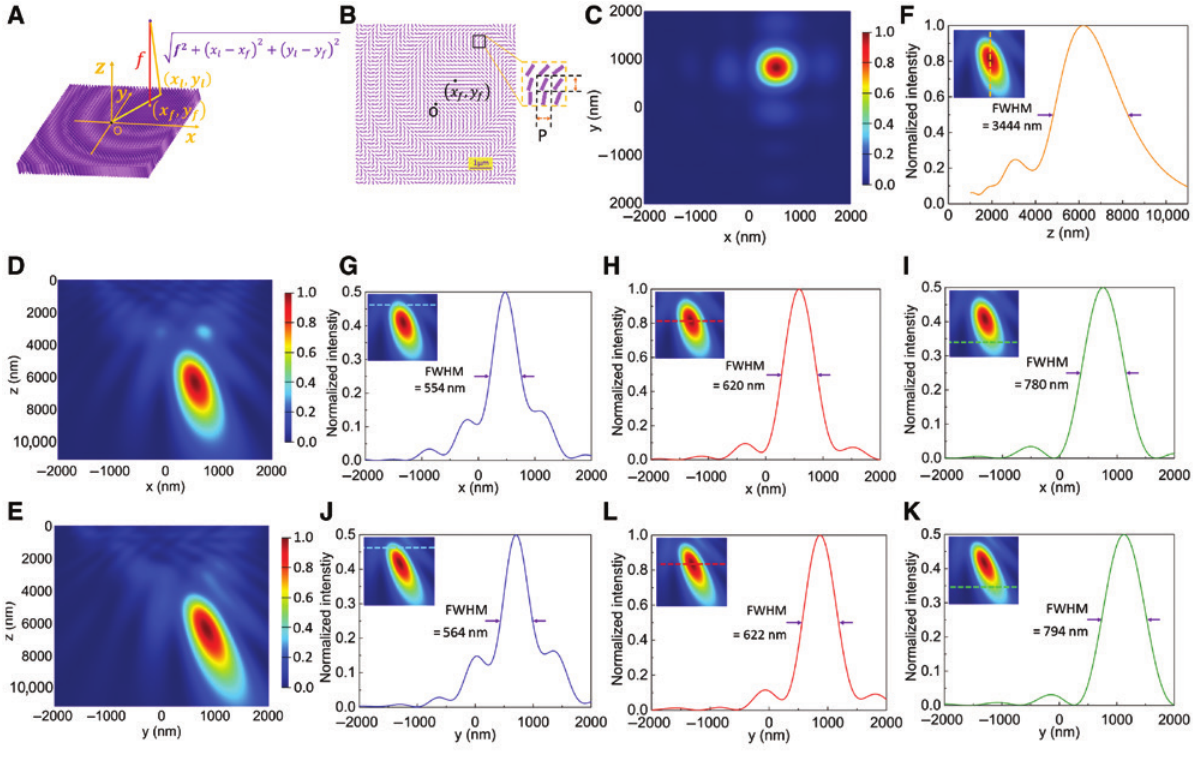
Figure 5: Out-of-plane focusing characteristics at UV-375 nm wavelength. (A) Schematic diagram of the focusing configuration, consisting of a two-dimensional array of AlN nanorods in the x - y plane, with different rotation angles as calculated according to Eq. (6). (B) Top view of the metalens, with unit cells of a fixed period equal to the dimension of the nanorods. Normalized RCP light intensity distribution across (C) the x - y section at z = 6.209 μ m, (D) the x - z section, at y = 0.87 μ m and (E) y - z section, at x = 0.59 μ m. (F) Normalized intensity profile along the z -axis, at x = 0.59 μ m and y = 0.87 μ m, with the peak located at z = 6.209 μ m. (G–I) Normalized intensity profile along the x -axis, at z = 4.811 μ m, z = 6.209 μ m and z = 8.255 μ m, respectively. (J–L) Normalized intensity profile along the y -axis, at z = 4.811 μ m, z = 6.209 μ m and z = 8.255 μ m, respectively. The two-dimensional array has the size of 4 μ m × 4 μ m, which means that there are 23 × 23 AlN nanorods in total. The NA is 0.196. The top surface of the metalens is located at z = 0. The insets of (F)–(I) and (J)–(L) are the enlarged view of the focal spot in (D) and (E), respectively, where the colored lines denote the position of the data extracted from the focal